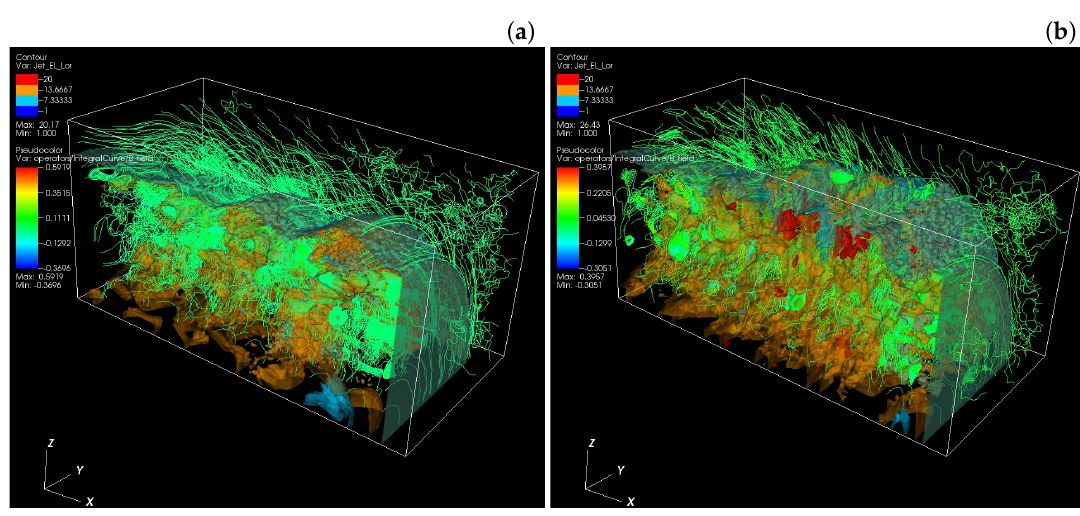
Figure 9. Panels show 3D isosurface plots of the Lorentz factor of the jet electrons for e − − p + ( a ) and e ± ( b ) jet with r jet = 120 ∆ at time t = 500 ω − 1 pe . The lines show the magnetic field stream lines in the quadrant of the front part of the jets. The color scales for contour (upper left): red 20.0; orange 13.67; right blue 7.33. blue 1. The color scales of streaming lines ( a ) (5.92, 3.52, 0.174, − 1.29, − 3.70) × 10 − 1 ; ( b ) (3.96, 2.21, 0.453, − 1.30, − 3.05) × 10 − 1 .